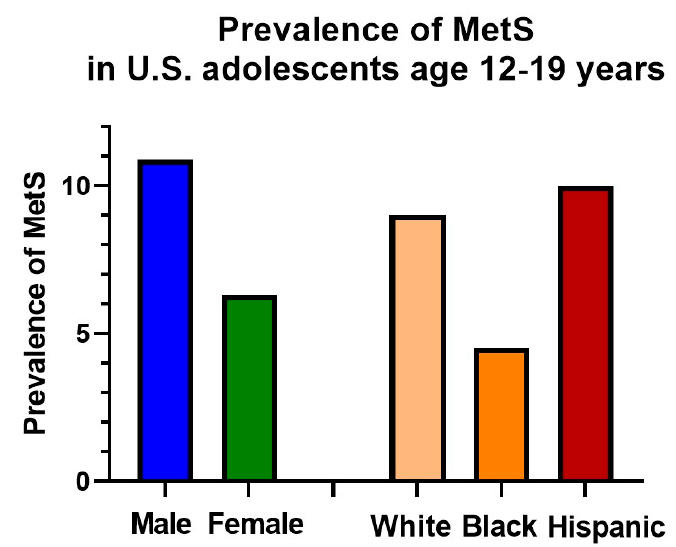
Figure 1. Prevalence of metabolic syndrome in adolescents by sex and race ethnicity. Data are for adolescent participants age 12–19 years from the National Health and Nutrition Examination Survey 1999–2012 as reported in Lee et al. [31].